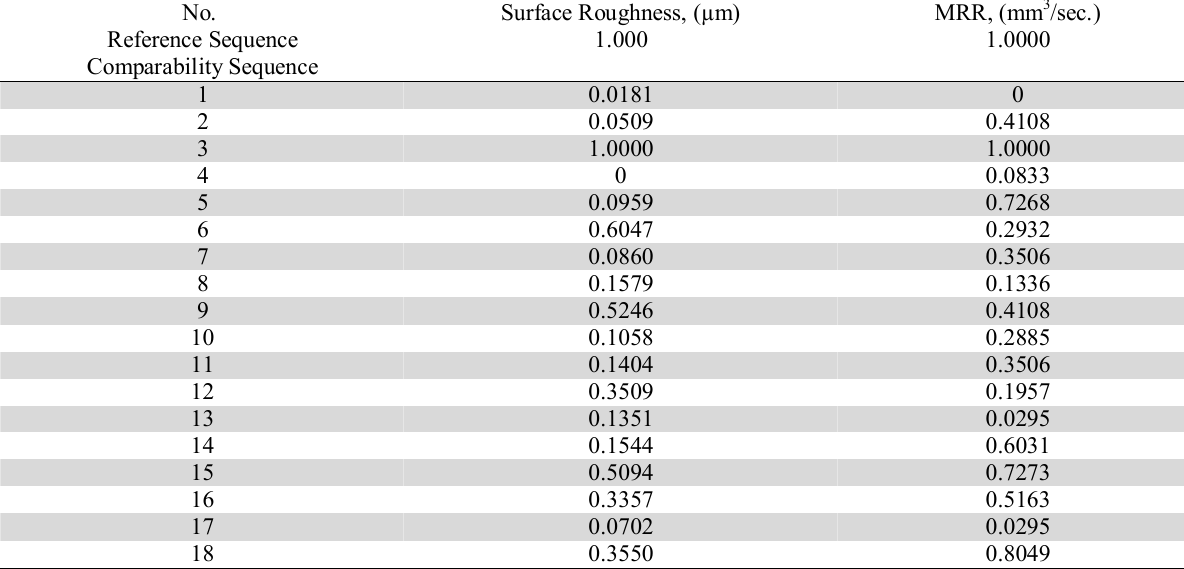
Sequence after Data Preprocessing